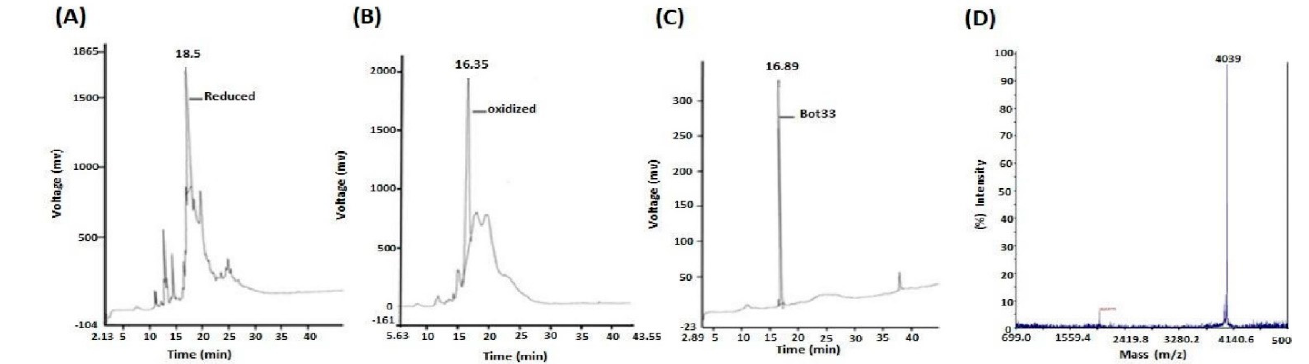
Figure 3. Bot33 at different stages of chemical synthesis: Analytical profiles of C18 reverse phase HPLC of Bot33 at different stages of its chemical composition synthesis. ( A ) The crude reduced peptide after the final TFA treatment. ( B ) The crude peptide after 48 h of oxidative folding. ( C ) Folded/oxidized purified Bot33. ( D ) The purity and identity of Bot33 assessed by mass spectrome- try.